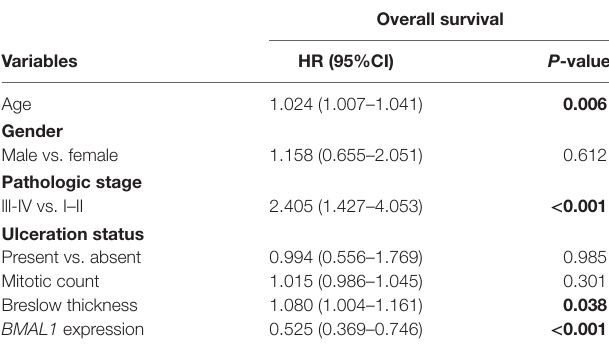
TaBle 2 | Multivariate Cox regression analysis of survival in The Cancer Genome Atlas metastatic melanomas.